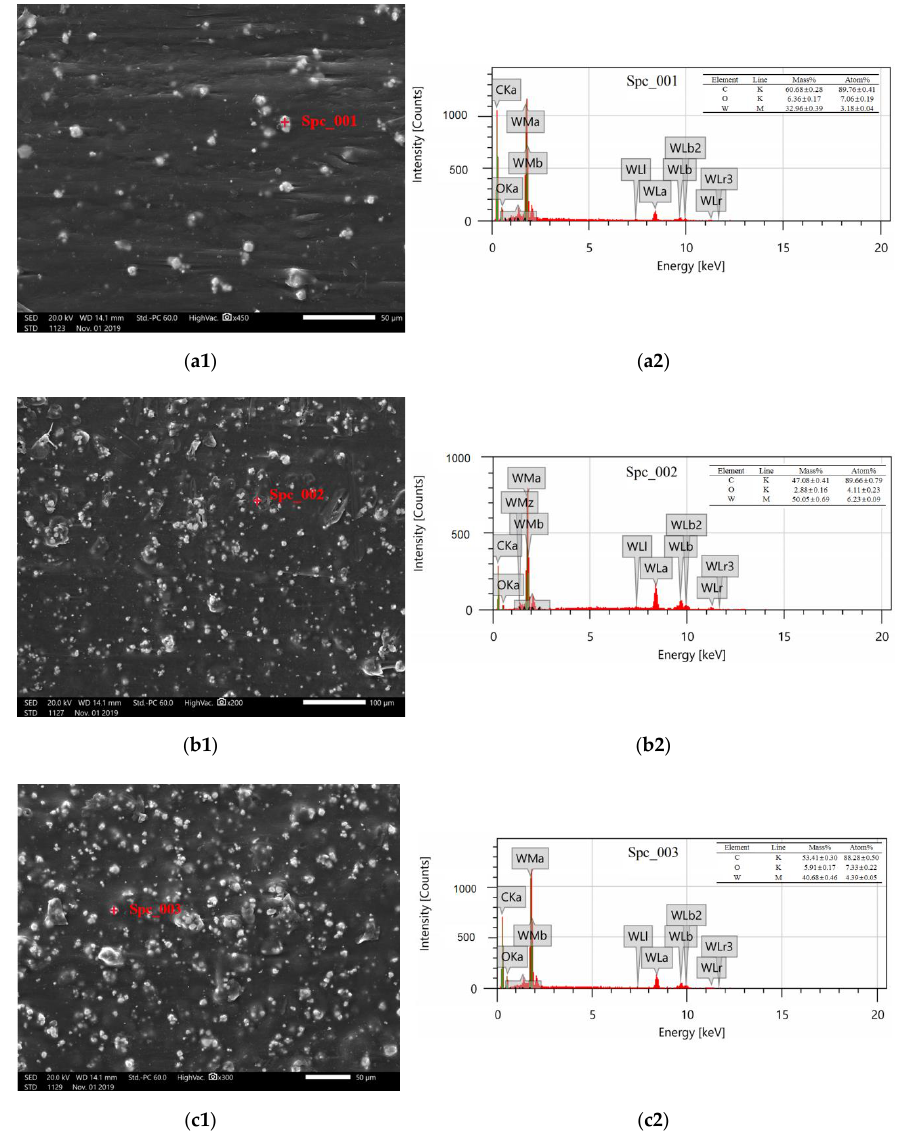
Figure 4. Microscope electron micrographs and EDS energy spectra of PEEK/tungsten composite materials: ( a1 ) electron micrograph of #1, ( a2 ) EDS energy spectrum of #1, ( b1 ) electron micrograph of #2, ( b2 ) EDS energy spectrum of #2, ( c1 ) electron micrograph of #3, and ( c2 ) EDS energy spectrum of #3.